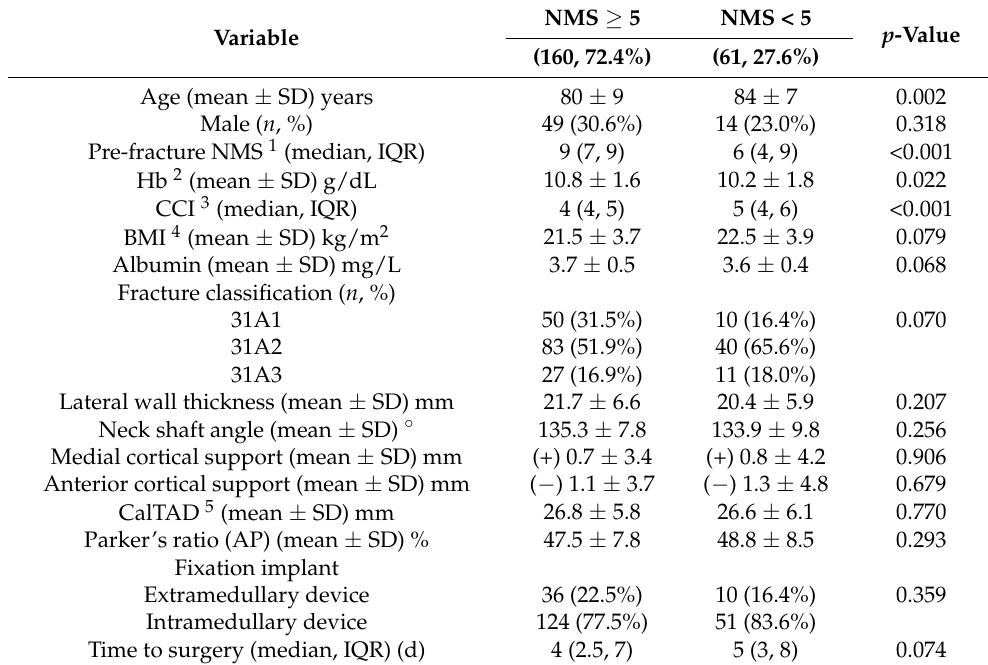
Table 1. Demographic data in 221 patients comparing between good functional outcome (NMS ≥ 5) and poor functional outcome (NMS < 5) and distribution after categorization.